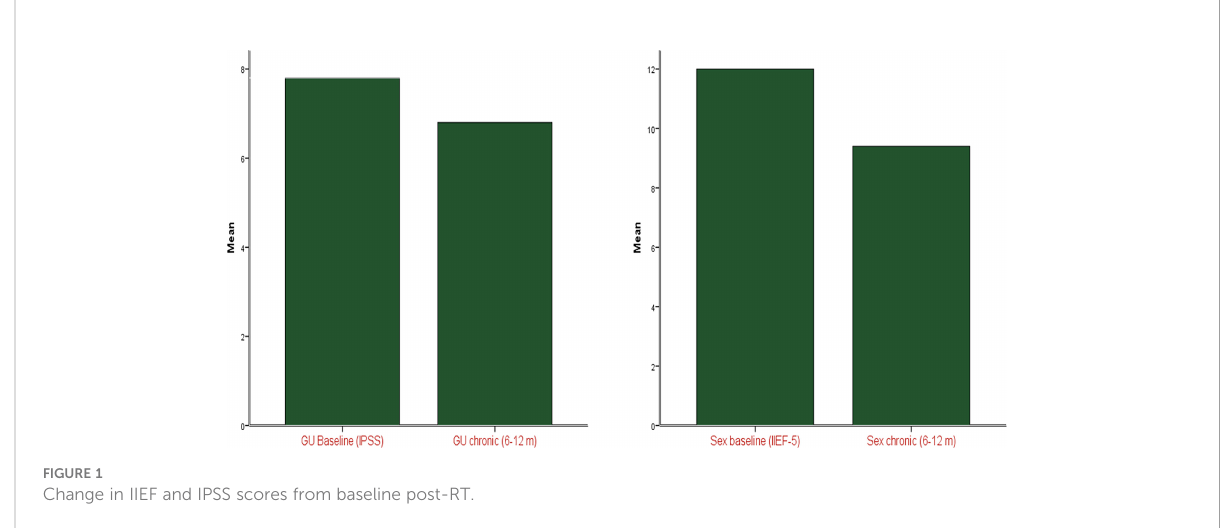
FIGURE 1 Change in IIEF and IPSS scores from baseline post-RT.